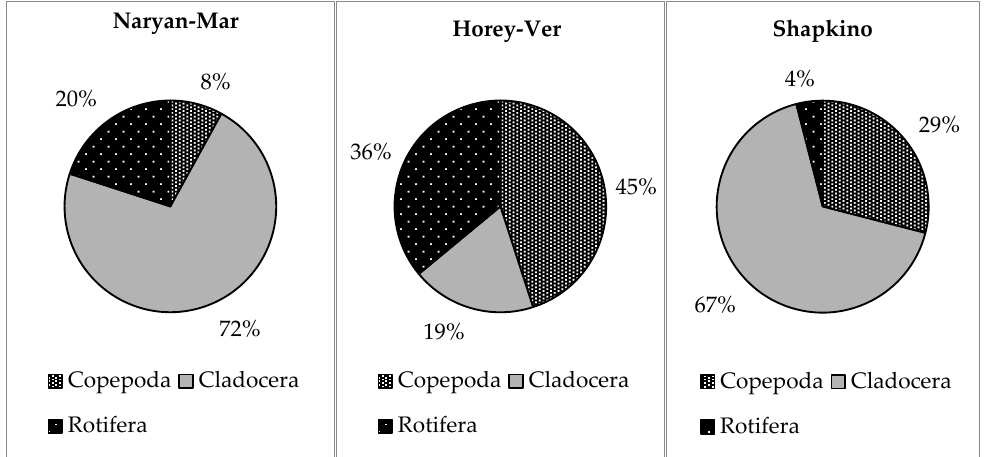
Figure 2. Contribution of major zooplankton groups to the total abundance in the zooplankton communities of various sites (August 2016).